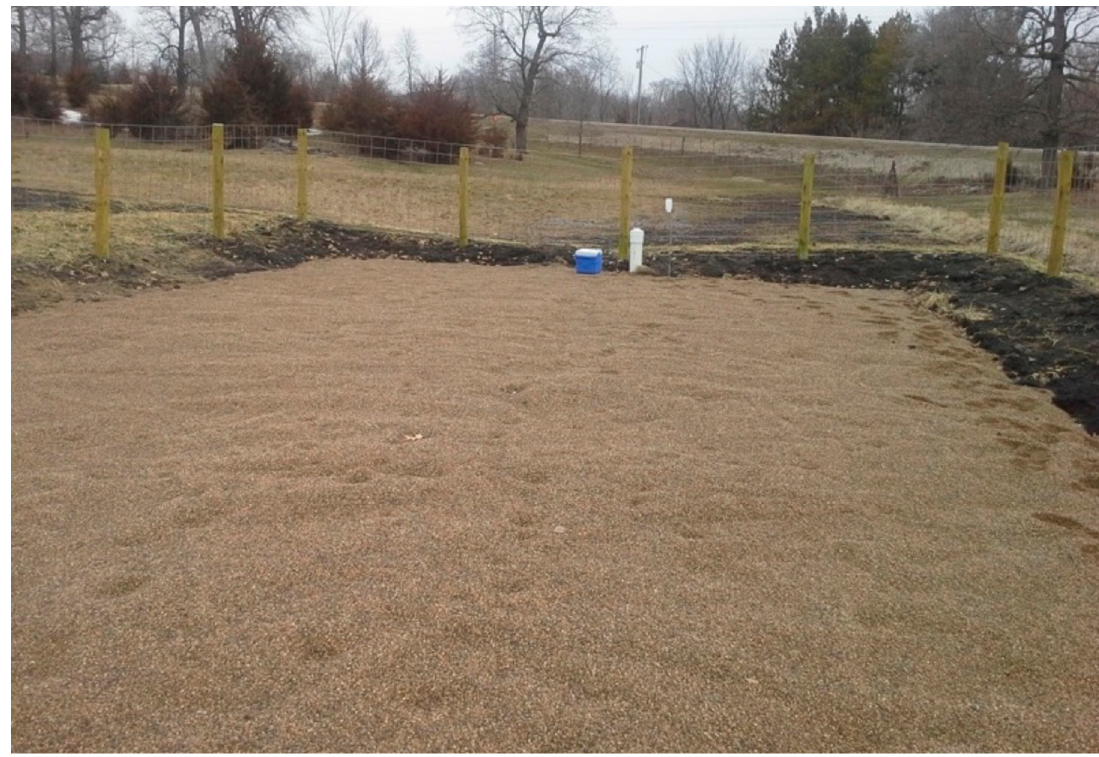
Figure 1. Site photo of Iron Enhanced Sand Filter (IESF) shortly after construction.